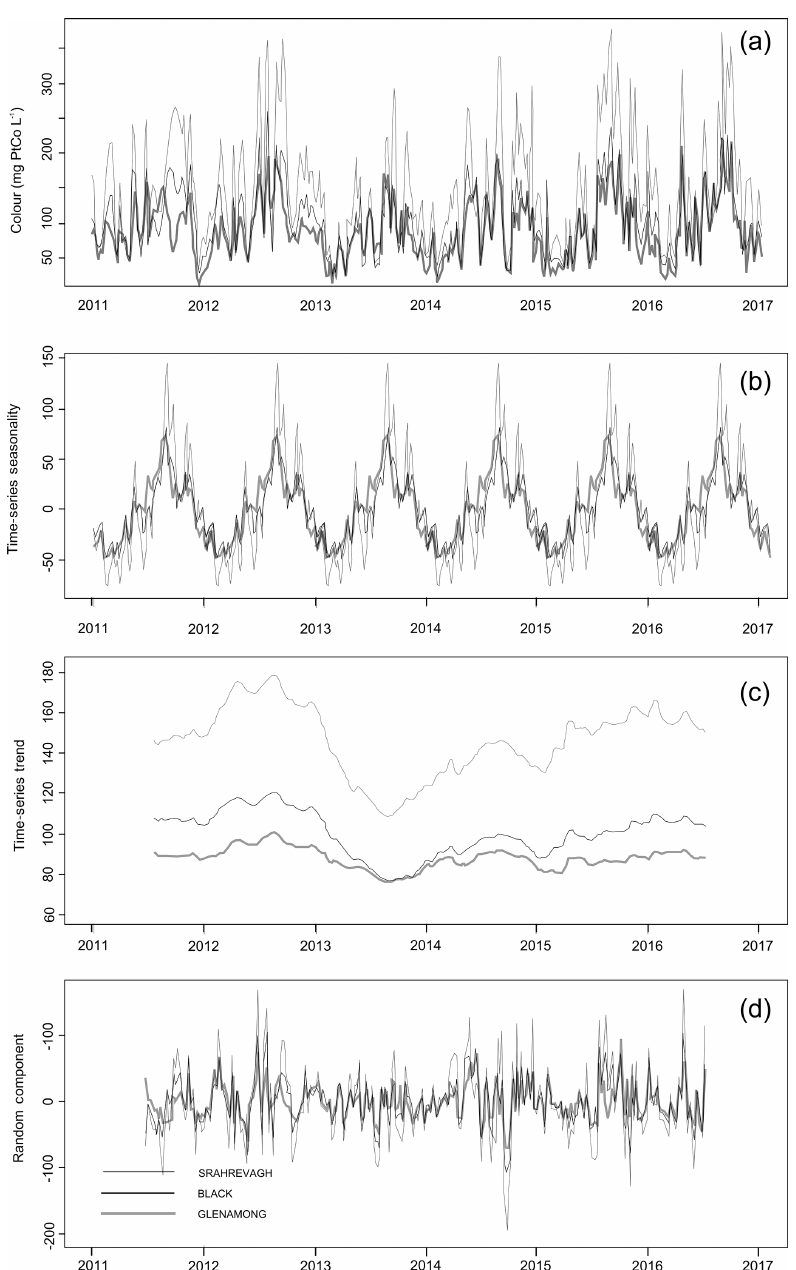
Figure 3. (a) Time series of colour concentrations (mgPtCoL − 1 ) measured weekly in the Black, Glenamong and Srahrevagh rivers from 2011 to 2017. Decomposition of the weekly water colour concentrations to the (b) inter-annual trend, (c) seasonal component and (d) random